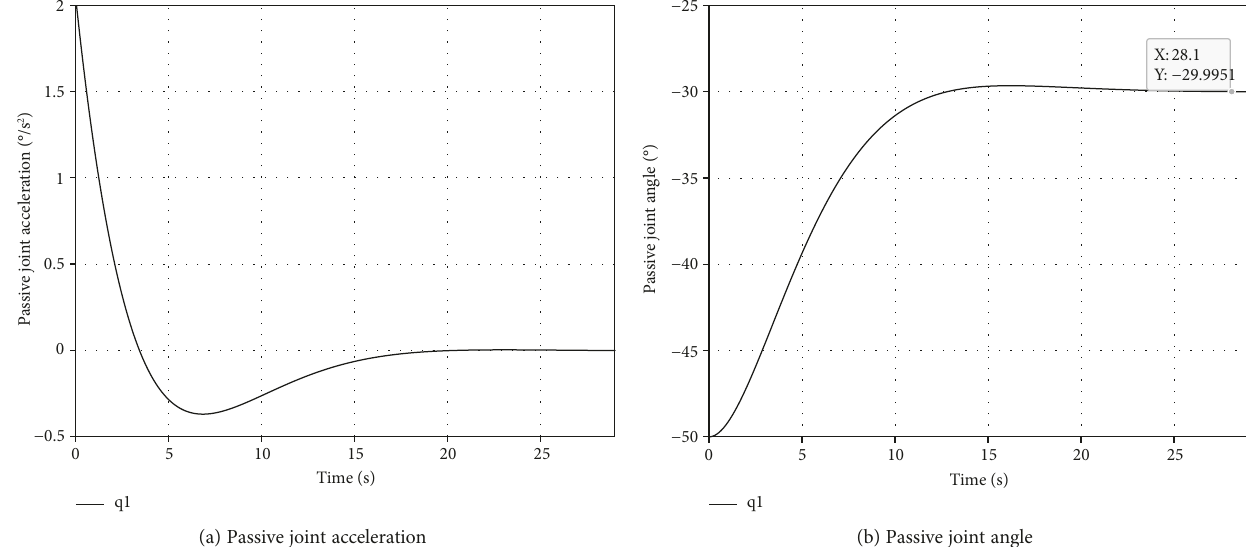
Figure 12: The motion of passive joints with the PD